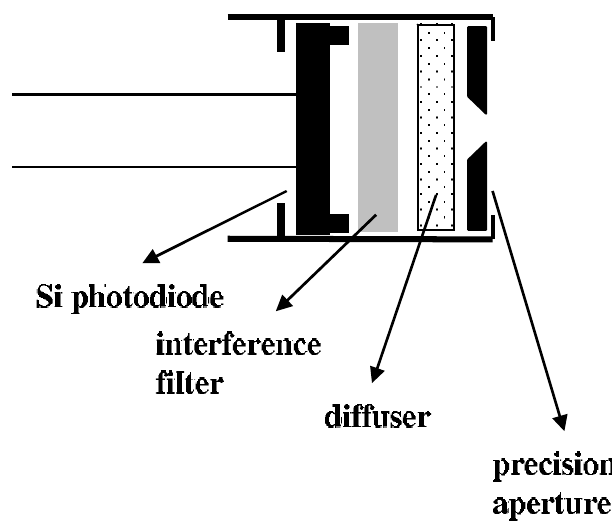
FIG. 4. Schematic diagram of a filter radiometer for synchro- tron radiation